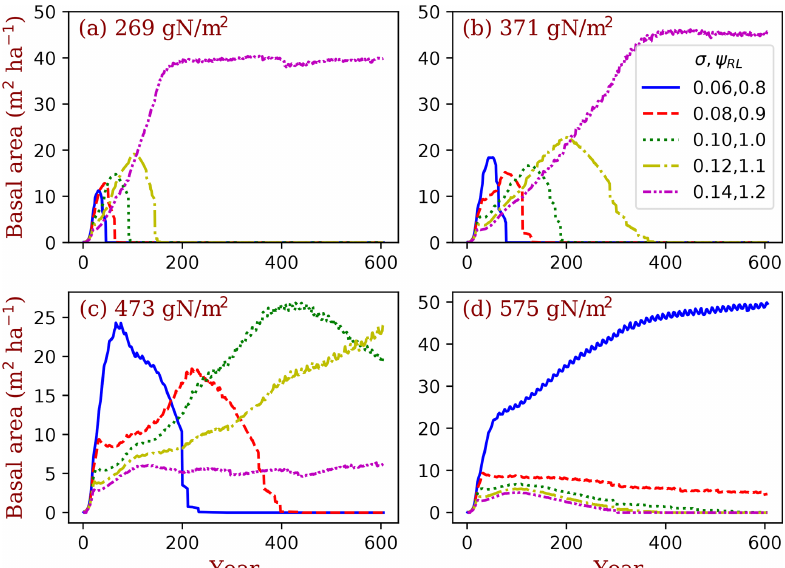
Figure 13. Simulated competitively dominant PFTs at different total ecosystem nitrogen. The simulations were set as nitrogen-closed (i.e., no input and output of nitrogen). The number in the title of each panel is the initial soil nitrogen. We used five PFTs that only differed in their LMA ( σ ) and target root/leaf area ratio ( φ RL ) corresponding to each LMA in each simulation. Basal area (the sum of all the trees’ trunk cross-sectional area) is used as the index of